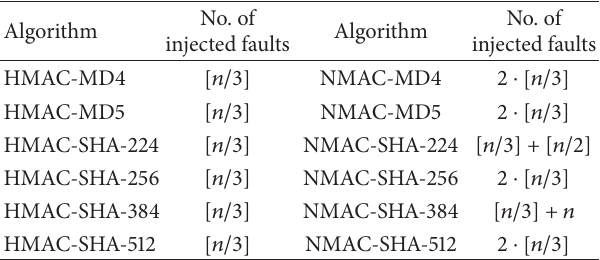
Table 1: Our attack results on HMAC/NMAC. Algorithm